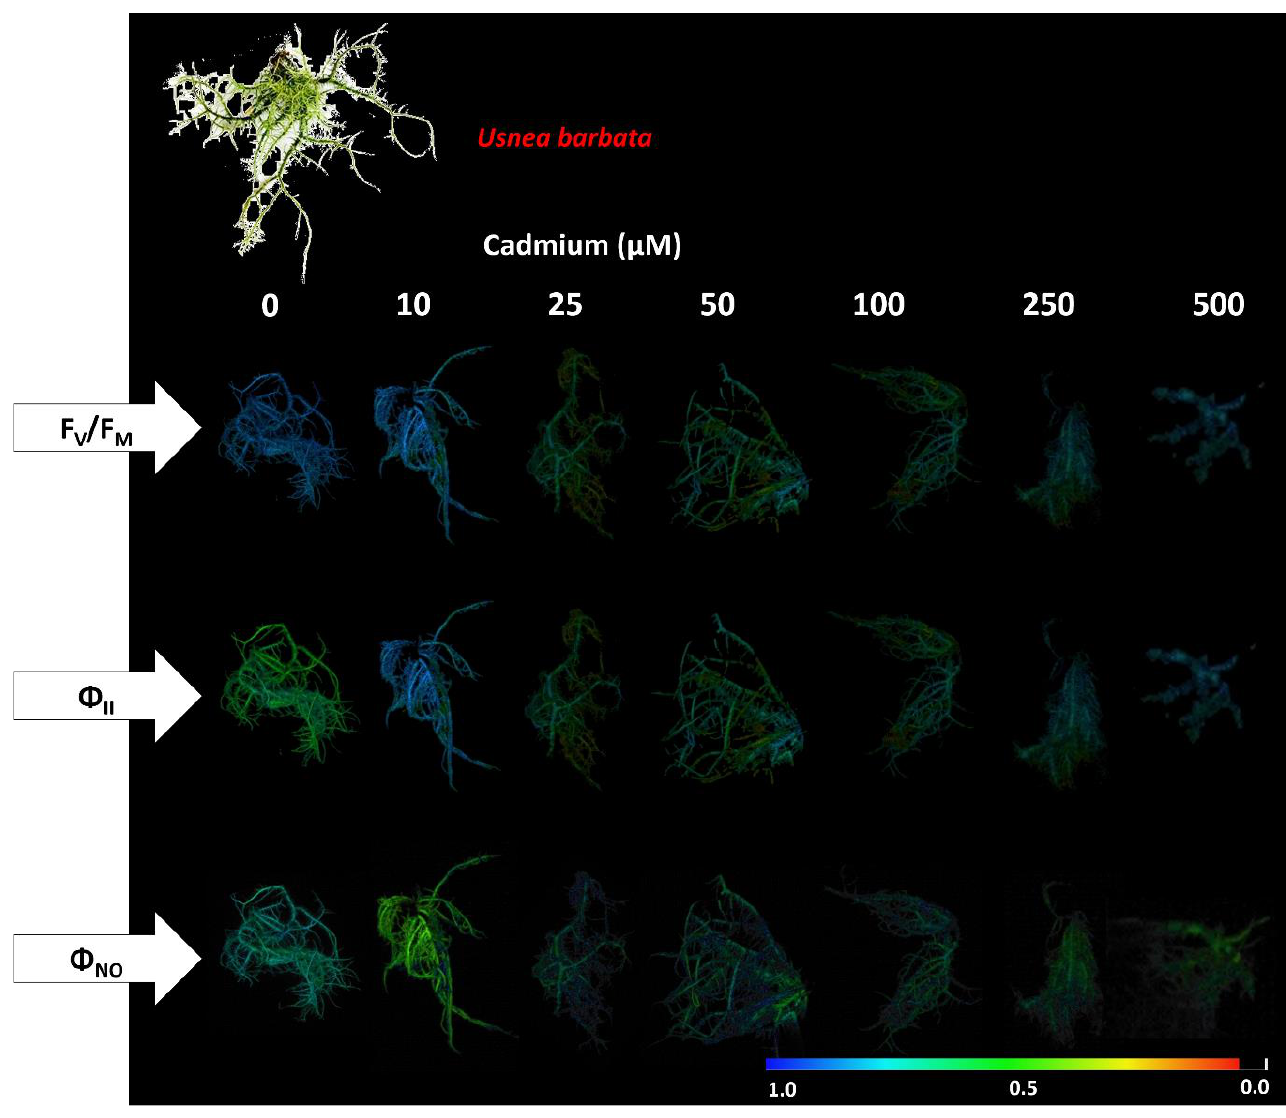
Figure 9. Chlorophyll a fluorescence parameters: FV/FM (maximum quantum efficiency of PSII photochemistry), ΦII (effective quantum yield of photochemical energy conversion in PSII), and ΦNO (quantum yield of unregulated energy dissipation) observed for the photobiont of the lichen Usnea barbata subjected to different concentrations of Cd (0, 10, 25, 50, 100, 250, and 500 µM).